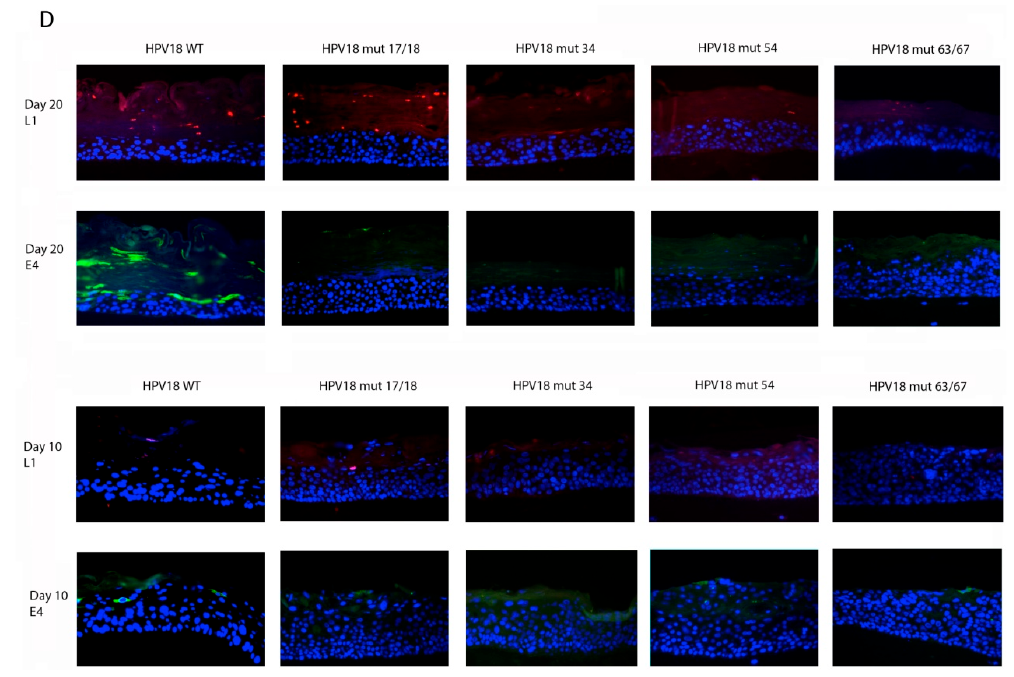
Figure 3. HPV18 virus titer, but not genomic replication or L1 synthesis is affected by mutations in E1^E4. Organotypic rafts harvested at either day 10 or day 20 of tissue growth were homogenized and both ( A ) total viral genomes and ( B ) viral titer were quantified. The total number of viral genomes were quantitated via a qPCR assay amplifying the E2 open reading frame and were measured against a standard curve of known concentrations of HPV genomes. To measure viral titer, homogenized samples were treated with benzonase to remove any non-protected HPV genomes. The quantity of protected viral genomes was then analyzed via qPCR against a standard curve of known concentrations of HPV genomes; ( C ) Western blot analysis of HPV18 L1 (equal loading as determined by Bradford Assay) from 10-day and 20-day WT and HPV18 E1^E4 mutant rafts. The blot was probed with the HPV18 L1 specific H18.7E antibody. The arrow points to HPV18 L1; ( D ) Immunofluorescent (IF) staining of 10—(bottom section) and 20—(top section) day raft tissue with HPV18 L1 (top rows, red) and E1^E4 protein (bottom rows, green). IF images are at 10× magnification. ( A , B ) Are averages from at least three individual experiments utilizing at least 2 different sets of rafts/virus preparations. Bars represent standard deviation. An asterisk (*) denotes significance by students t -test. Statistical significance was defined as p ≤ 0.05. ( C ) is representative of at least two different western blots (WBs) with samples from at least 2 different rafts/virus preparations. IF staining is representative of at least two different raft tissues from two different HPV18 WT and mutant cell lines.